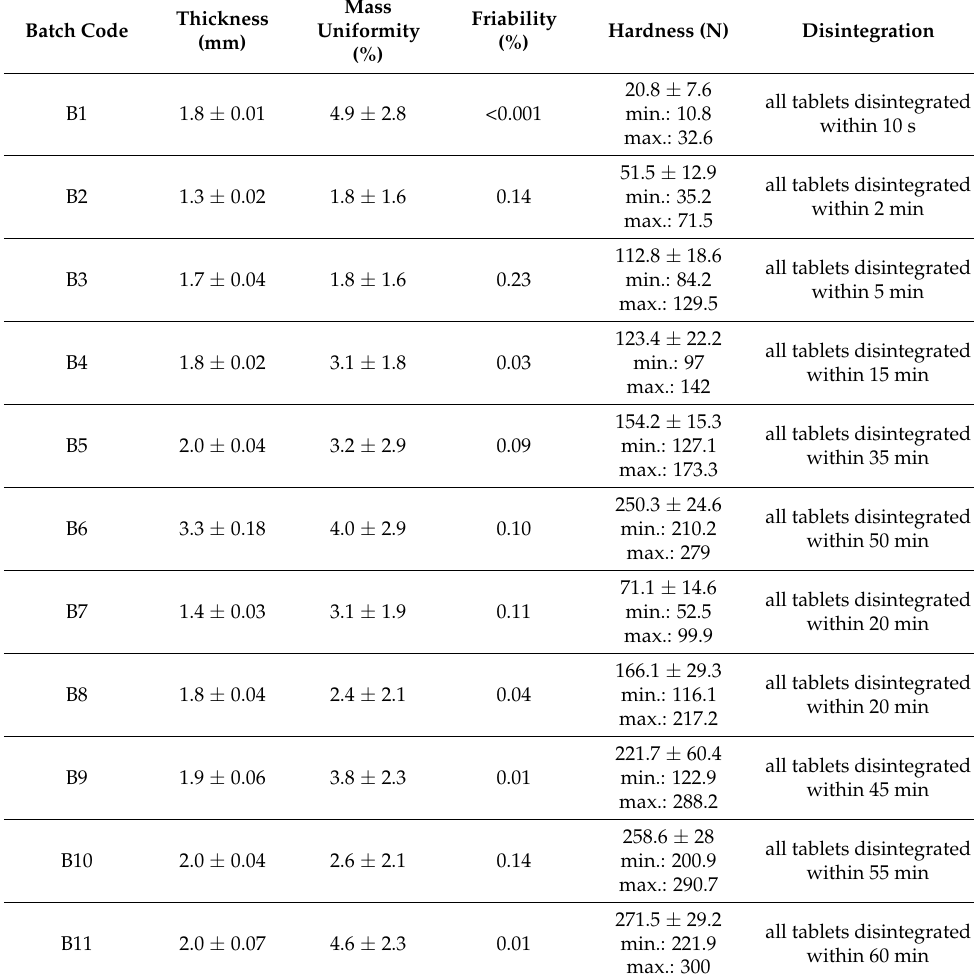
Table 3. Physico-chemical properties of the different paper granules produced in this study. Mass Thickness Batch Code (mm)